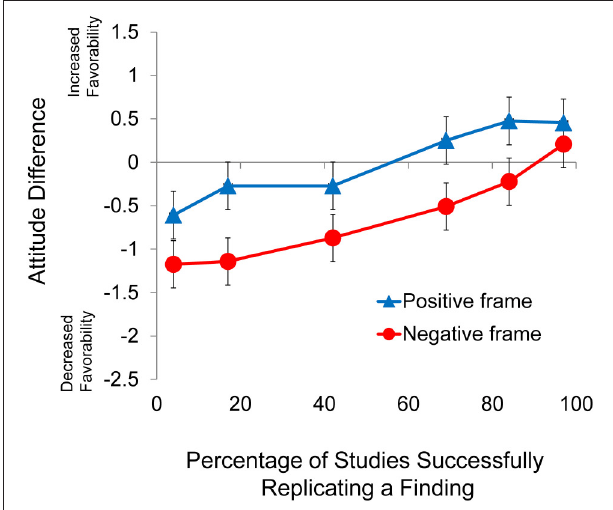
FIGURE 2 | Difference score as a function of frame for Experiment 2. Error bars indicate 95% confidence